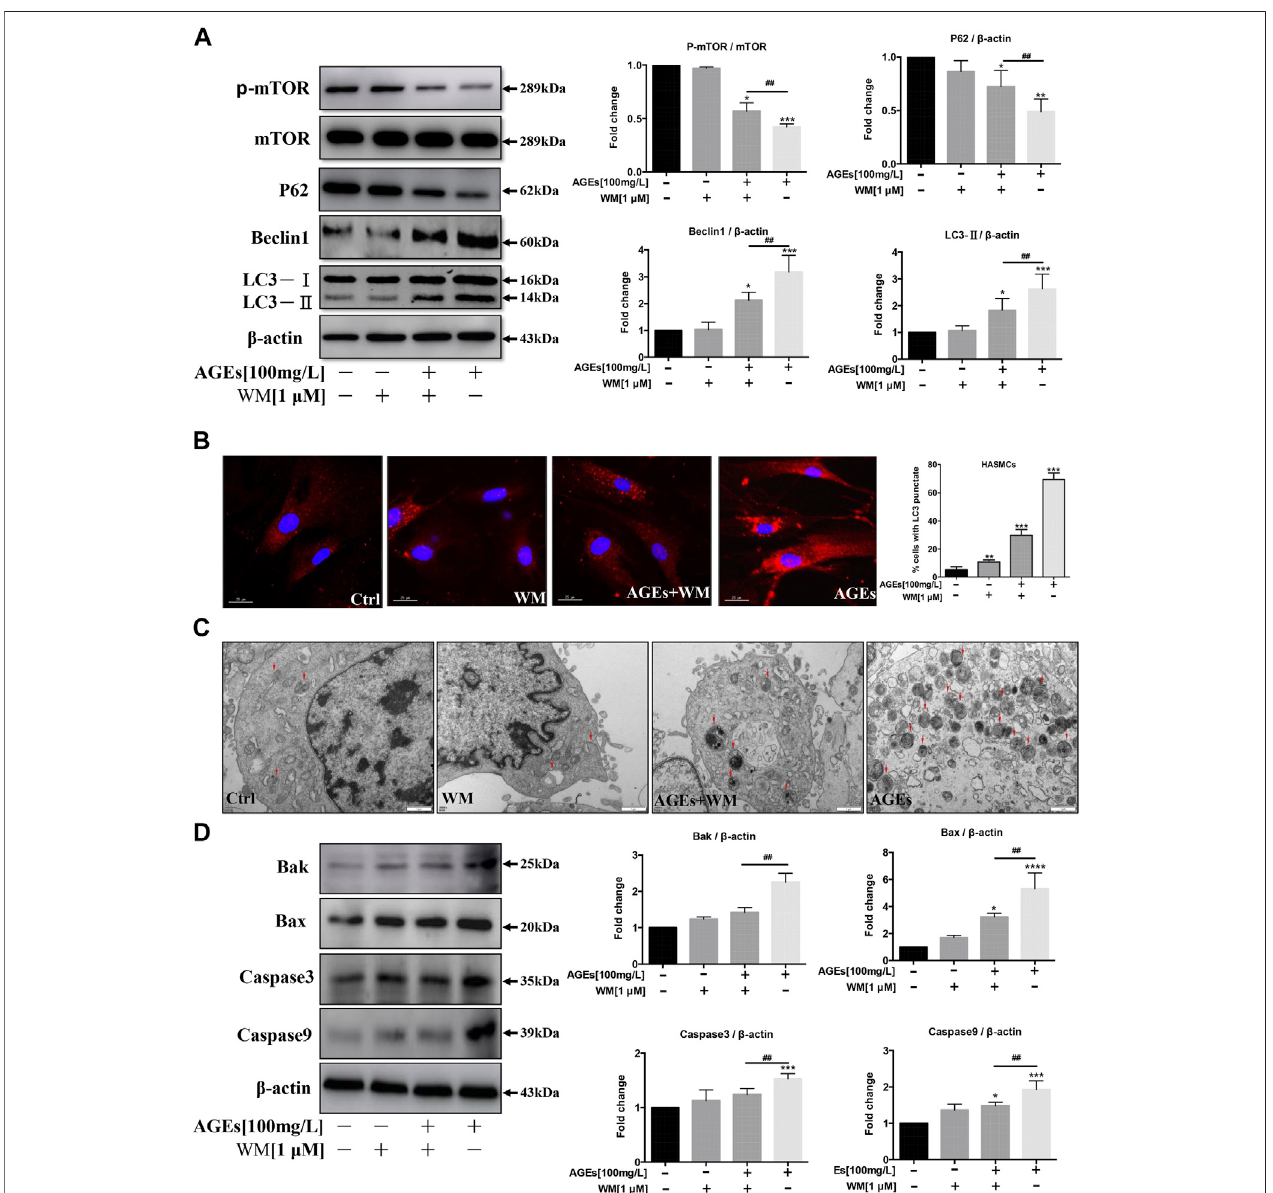
FIGURE4| EffectsofanautophagyinhibitoronautophagyandapoptosisinHASMCs.Afterpretreatmentwithwortmannin(WM)for1 h,HASMCswereincubated with AGEs (100 µg/ml) for another 24 h (A) WM suppressed AGEs-induced autophagy marker expression in HASMCs. Western blot analysis of autophagy proteins (LC3, beclin1, p62, and p-mTOR) in HASMCs treated with WM and AGEs for 24 h (B) WM abolished AGEs-induced autophagic puncta formation in HASMCs. Immuno fl uorescence analysis of LC3-II puncta formation (red color represents LC3-II, blue represents DAPI; scale bar (cid:2) 25 μ m). (C) TEM evidence of autophagic vacuoles(redarrows),bars:1 μ m. (D) WesternbDlotanalysisofapoptosis-relatedproteins(Bak,Bax,caspase-3,andcaspase-9)inWM/AGEs-treatedHASMCs.Data arepresentedasfoldchangecomparedwiththecontrolgroup.Eachpointrepresentsthemean ± SD( n (cid:2) 3/group); *p < 0.05, ** p < 0.01, *** p < 0.001comparedwiththe WM/AGEs-treated group; # p < 0.05, ## p < 0.01, ### p < 0.001.